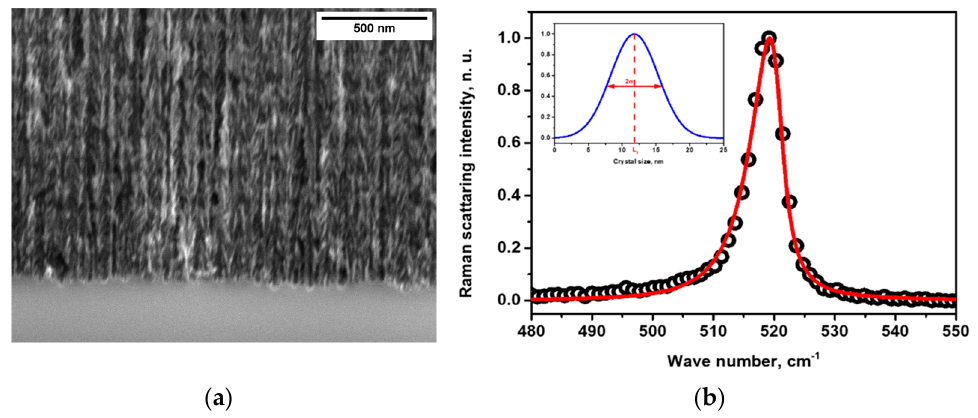
Figure 1. ( a ) SEM picture of a typical porous Si layer with 70% porosity; ( b ) fitting (red line) of a typical Raman spectrum (open circles) of a porous Si layer, in terms of a model allowing the estimation of the Gaussian-shape size distribution (blue curve) of Si nanocrystallites forming the porous layer. Table 1. Porosity-dependent size distribution of Si nanocrystallites. Porosity, % Thickness, µ m